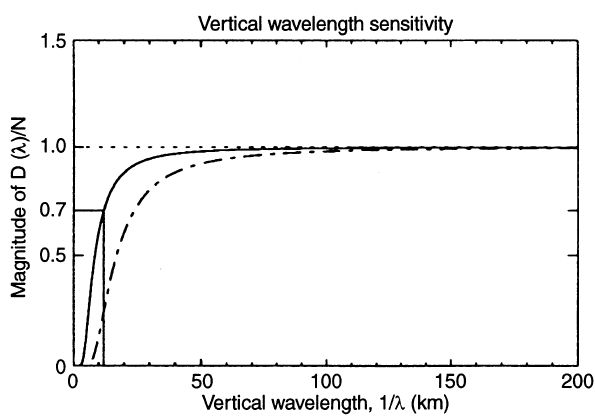
Fig. 1. The sensitivity of the South Pole meteor radar system to waves with di(cid:128)ering vertical wavelengths is shown. The solid line ( dashed line ) indicates the sensitivity assuming a meteor region with a halfwidth of 10km (20km). The solid vertical line indicates the 3dB point for the 10 km meteor region which occurs at a vertical wavelength of